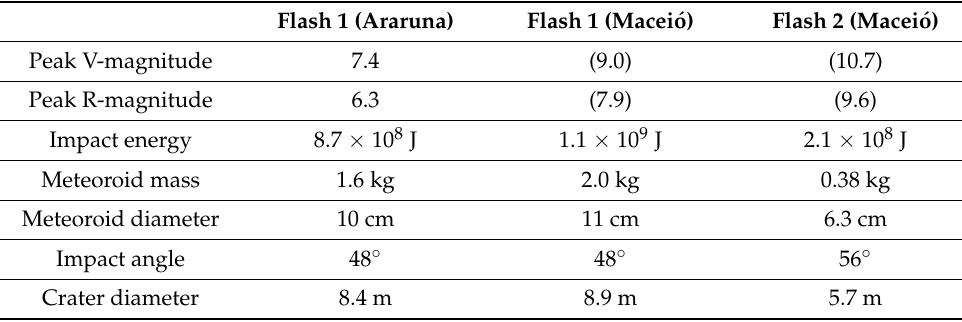
Table 1. Summary of the results obtained from the